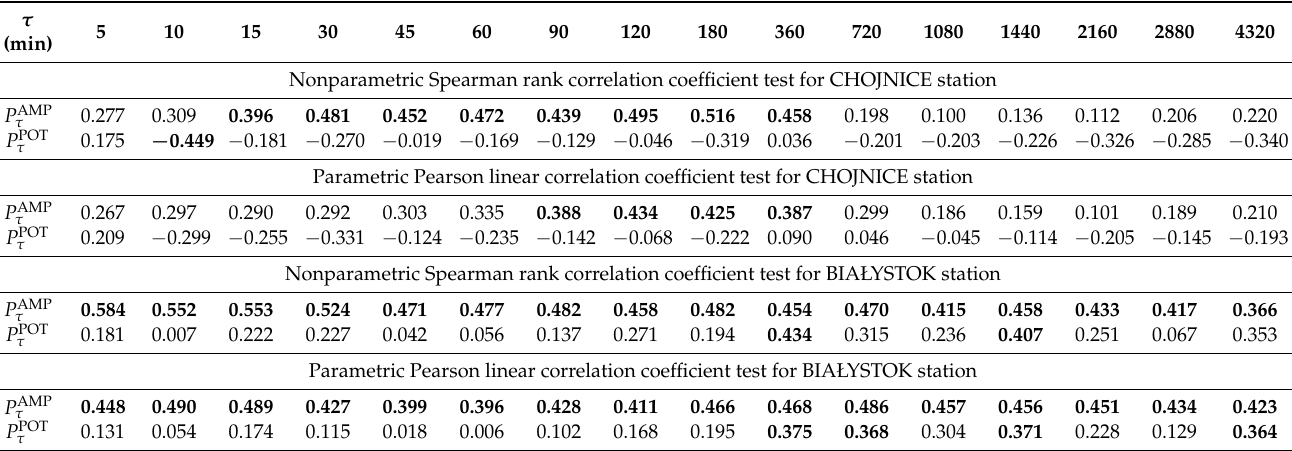
Table 4. Correlations between the maximum precipitation variables and time τ for the Chojnice and Bialystok stations. Bold values of Spearman’s rank correlation and Pearson’s linear correlation coefficients are significant at p < 0.05 for n = 30, where n is the size of the sample.